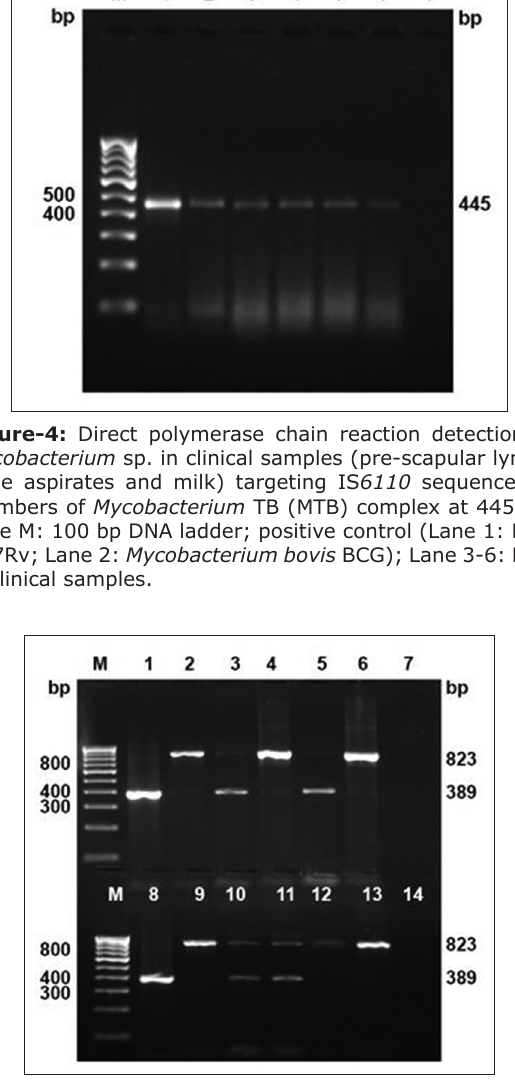
Figure-5: Species differentiation of Mycobacterium TB (MTB) complex members in clinical samples (pre-scapular lymph node aspirates and milk) by multiplex-polymerase chain reaction targeting 12.7 kb fragment sequence